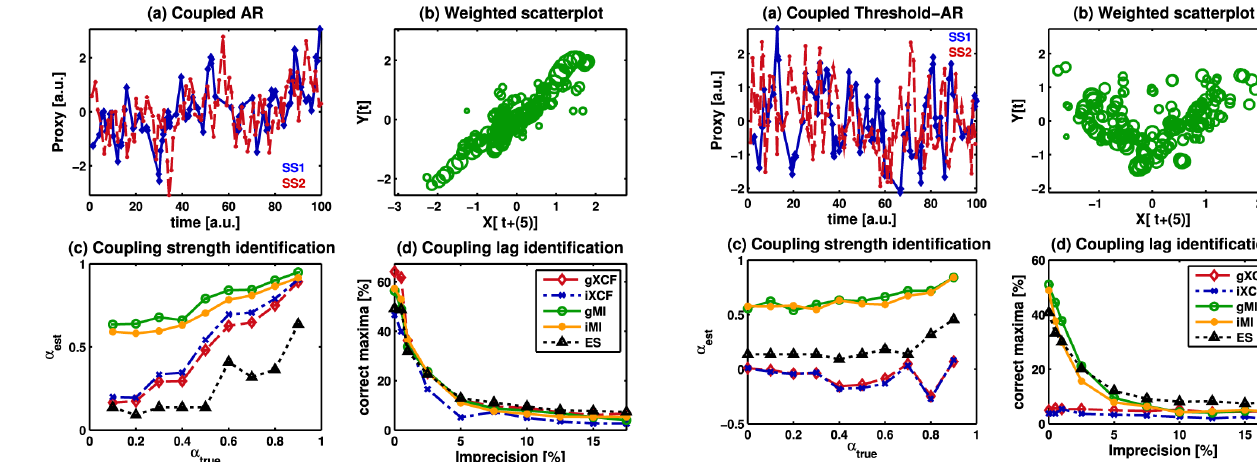
Fig. 4. Testing the similarity measures: for linearly coupled AR time series (cf.Eq.16) from two synthetic stalagmites, SS1 and SS2, we give the sample time series (a) and the Gaussian weighted scatter plot (b) . We check the monotonicity of the estimators with increas- ing coupling strength (c) and how often the maximum of the simi- larity function correctly coincides with the lag of coupling (d) .